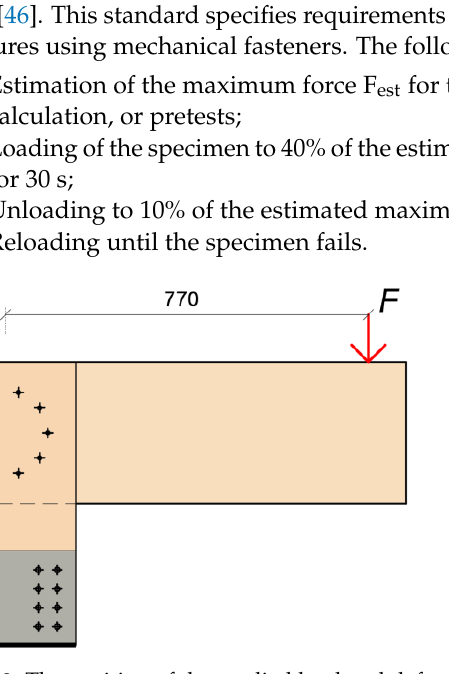
Figure 3. The position of the applied load and deformation measurement.